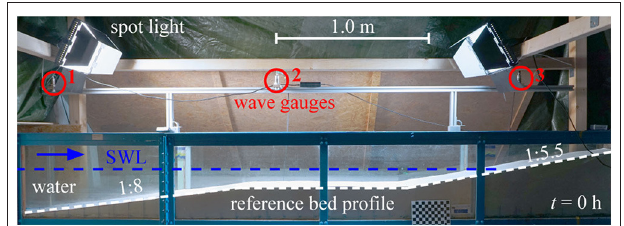
FIGURE 3 | Camera observation section of the reference bed profile (dashed white line) and the still water line (SWL, dashed blue line) in the wave flume ( t 0 h ). Position of the three ultra-sonic wave gauges (red circles) and spot = lights for even camera exposure during experiments.